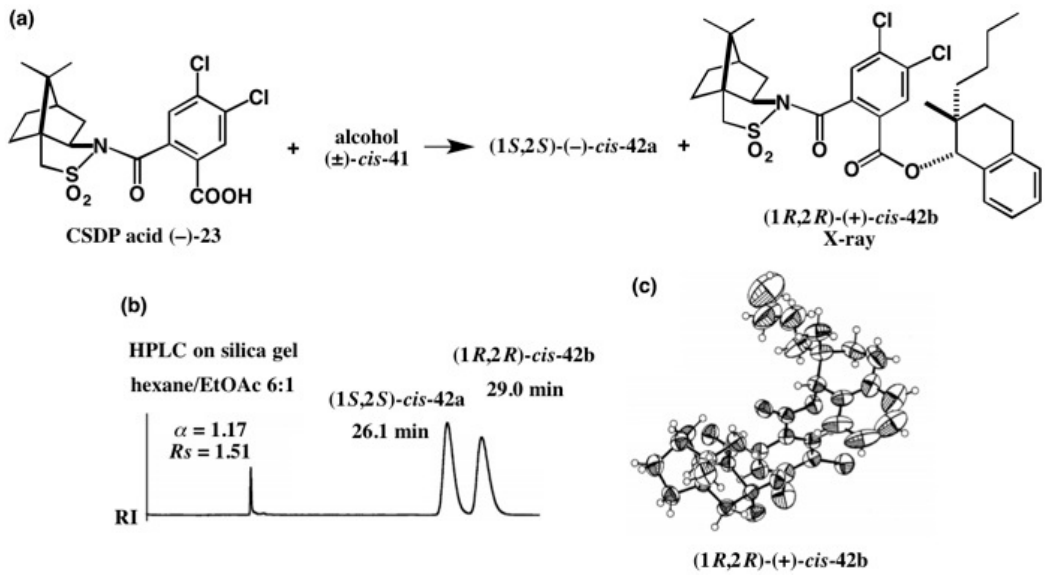
Figure 28. Preparation ( a ) and HPLC separation ( b ) of CSDP esters 42a and 42b , and the AC determination of ester (1 R ,2 R )-(+)- cis - 42b by X-ray crystallography ( c ). HPLC and ORTEP, reprinted with permission from [45].